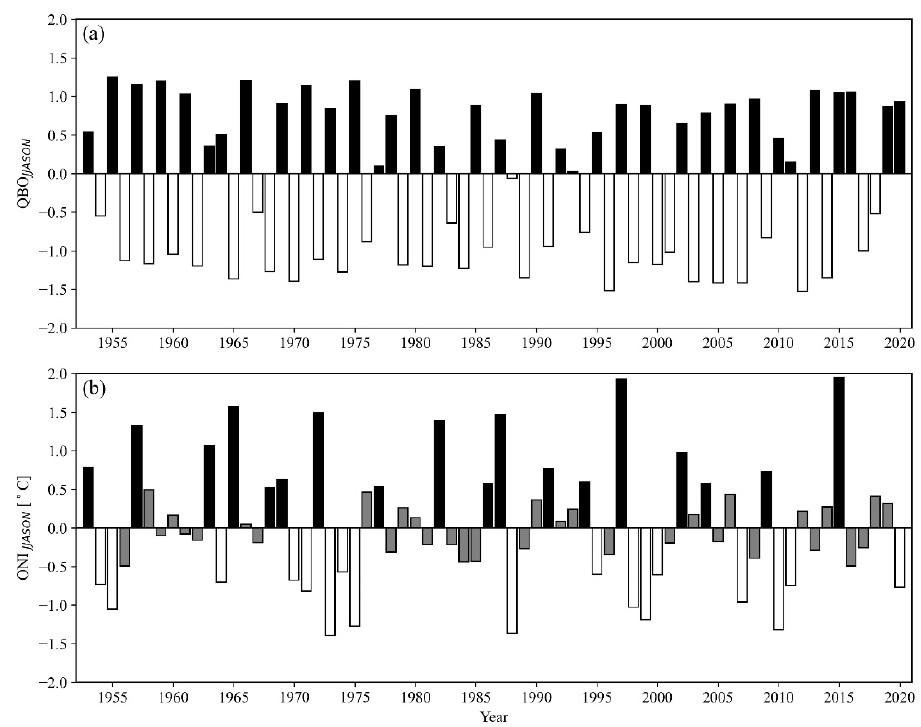
Figure 1. Time series of the mean values of QBOI ( a ) and ONI ( b ) for the season JJASON per year. For the QBO time series, black and white bars represent the W and E phases, respectively. For the ONI time series, black, grey, and white represent El Niño, Neutral, and La Niña phases.